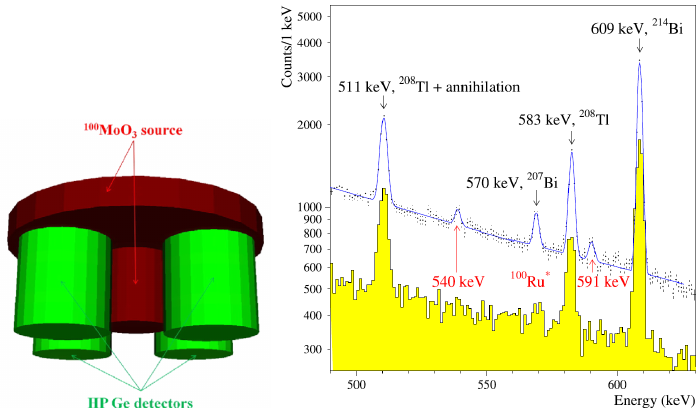
Figure 5. ( left ) Schematic view of the 100 MoO 3 source and the four HP-Ge detectors used in the ARMONIA experiment (only the source and the detectors are shown). ( right ) Energy spectrum collected by the ARMONIA experiment with the 100 MoO 3 sample (points with error bars) in the 490–630 keV energy interval together with its fit (continuous curve). The background spectrum (normalized to 18120 h) is also shown (filled histogram). Both peaks at 539.5 keV and 590.8 keV due ) are clearly visible in the 100 MoO to the 2 β − decay 100 Mo → 100 Ru ( 0 + 3 spectrum. Reprinted from 1 Reference [28] with permission from